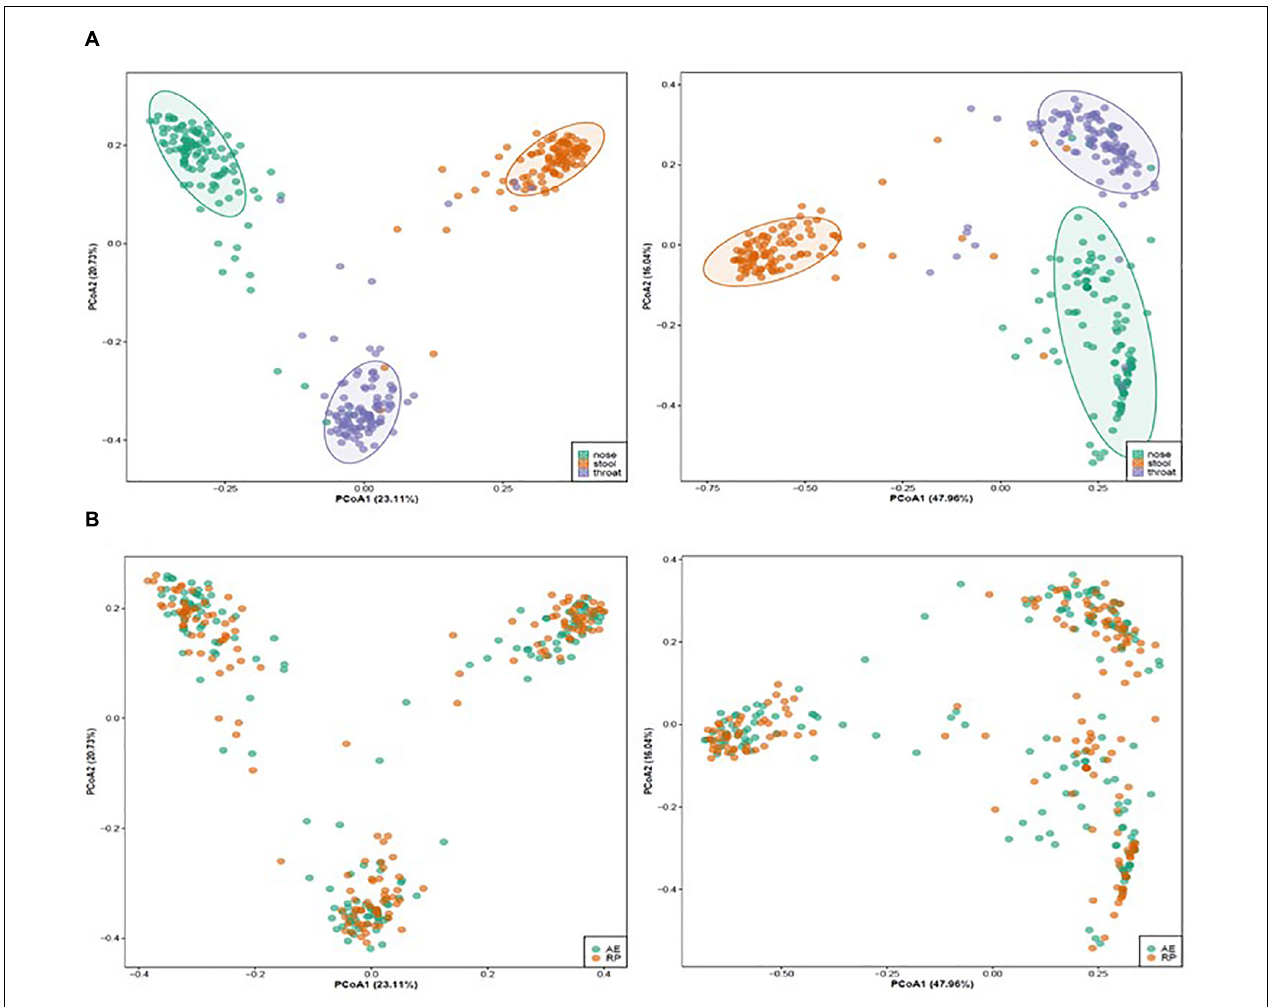
FIGURE 1 | Un-weighted (left) and weighted (right) principal coordinate analysis of microbiota of asthmatic children colored by (A) body site (nose: green, throat: purple, stool: orange) and (B) asthmatic status (AE, green; RP,